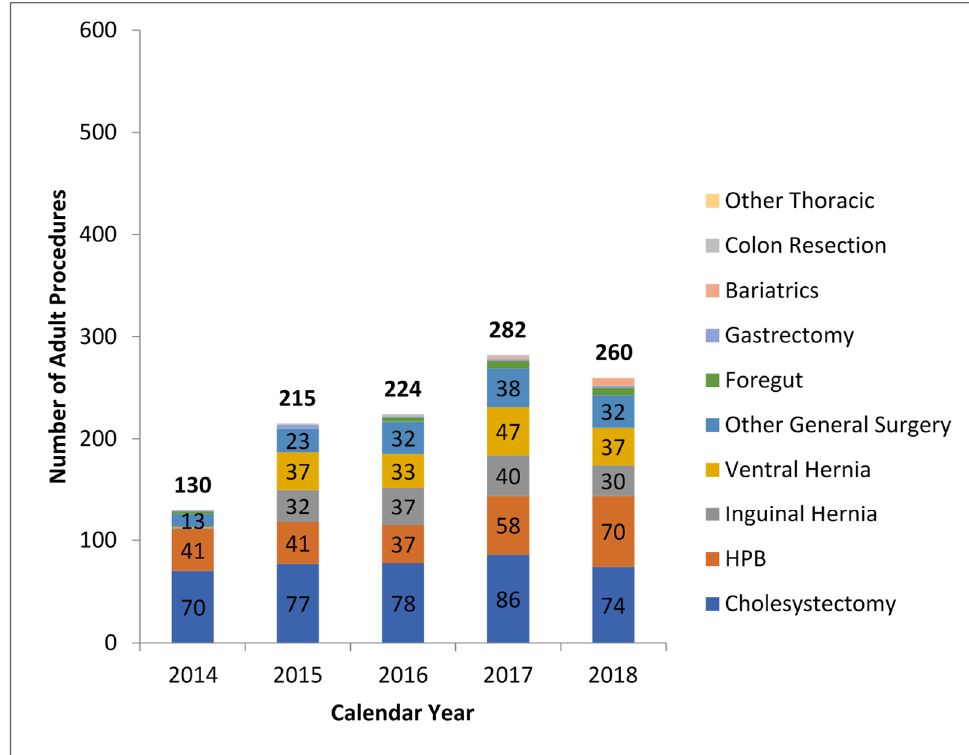
Figure 4. Yearly robotic procedure evolution .